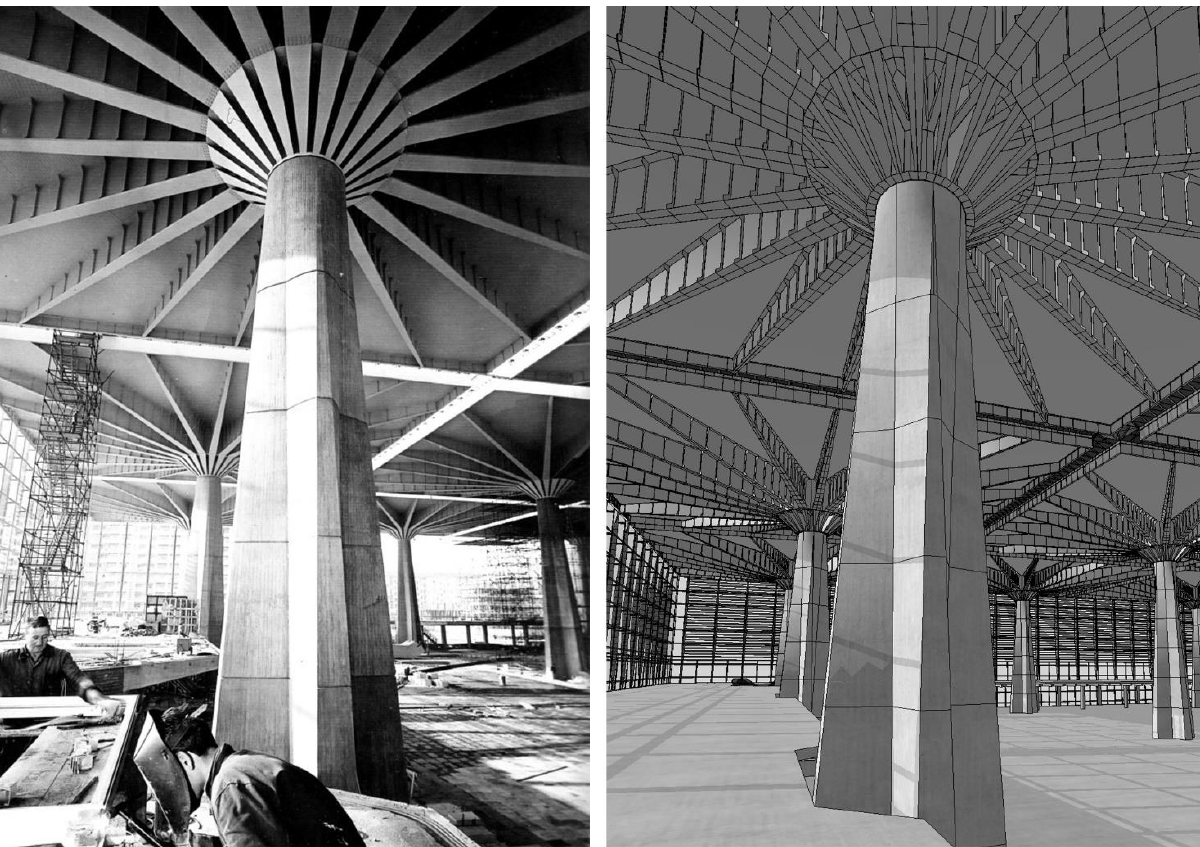
Figure 3: comparison between a a photo of the construction site, Sergio Poretti’s archive Rome (on the left), with a perspective view of the BIM model (on the